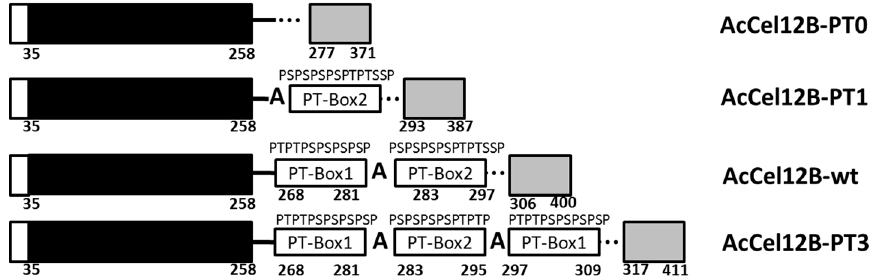
Figure 1. Schematic representation of the structures of wild-type and mutant AcCel12B. Structures of native full-length thermophilic cellulase, AcCel12B (the numbering corresponds to the amino acid sequence of the mature protein), and its mutants, AcCel12B-PT0, AcCel12B-PT1, and AcCel12B-PT3. The signal peptides are represented by the open boxes, the CDs by black boxes, the LRs by continuous line, and the CBMs by gray boxes. The rectangles on the LR correspond to the PT/S-Box. PT: Proline-Threonine. PS: Proline-Serine. CD: Catalytic domain. LR: Linker region. CBM: Carbohydrate-binding module.